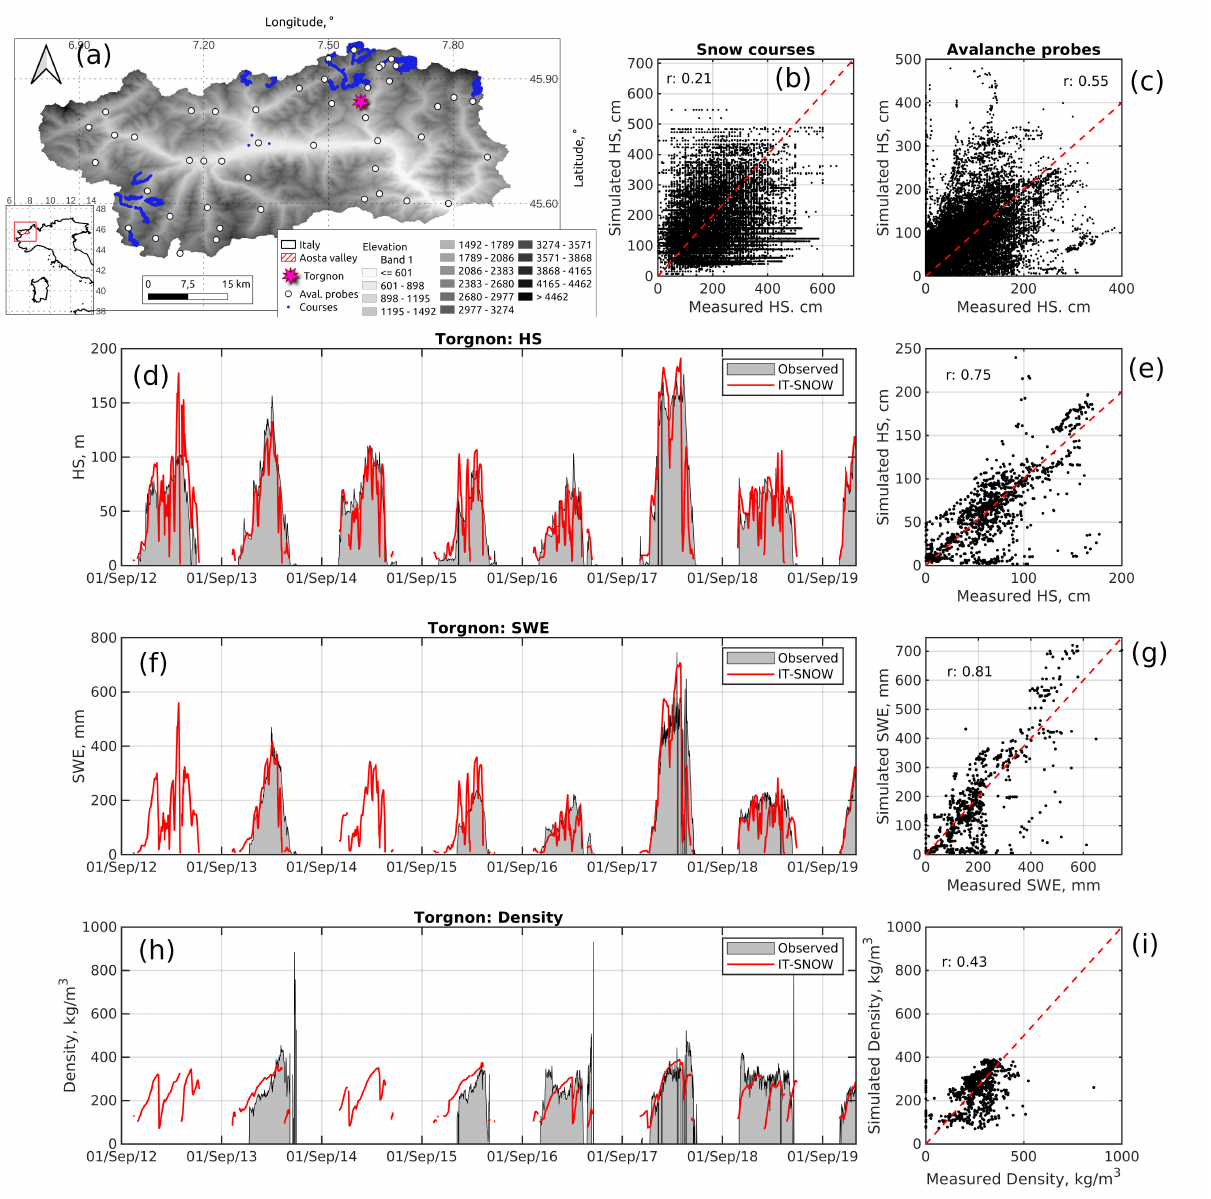
Figure 6. Evaluation of IT-SNOW in Aosta Valley. (a) Topography of the focus region, along with sampling location of evaluation data. Panels (b) and (c) show observed vs. simulated snow depth at snow course and avalanche probe locations. Panels (d) and (e) show simulated vs. observed snow depth at Torgnon. Panels (f) and (g) show simulated vs. observed SWE at Torgnon. Panels (h) and (i) show simulated vs. observed bulk snow density at Torgnon. Note that simulated snow depth, SWE, and density in panels (d) , (f) , and (h) were smoothed using a 5d moving window for readability. r is Pearson’s correlation coefficient, HS is snow depth, and SWE is snow water